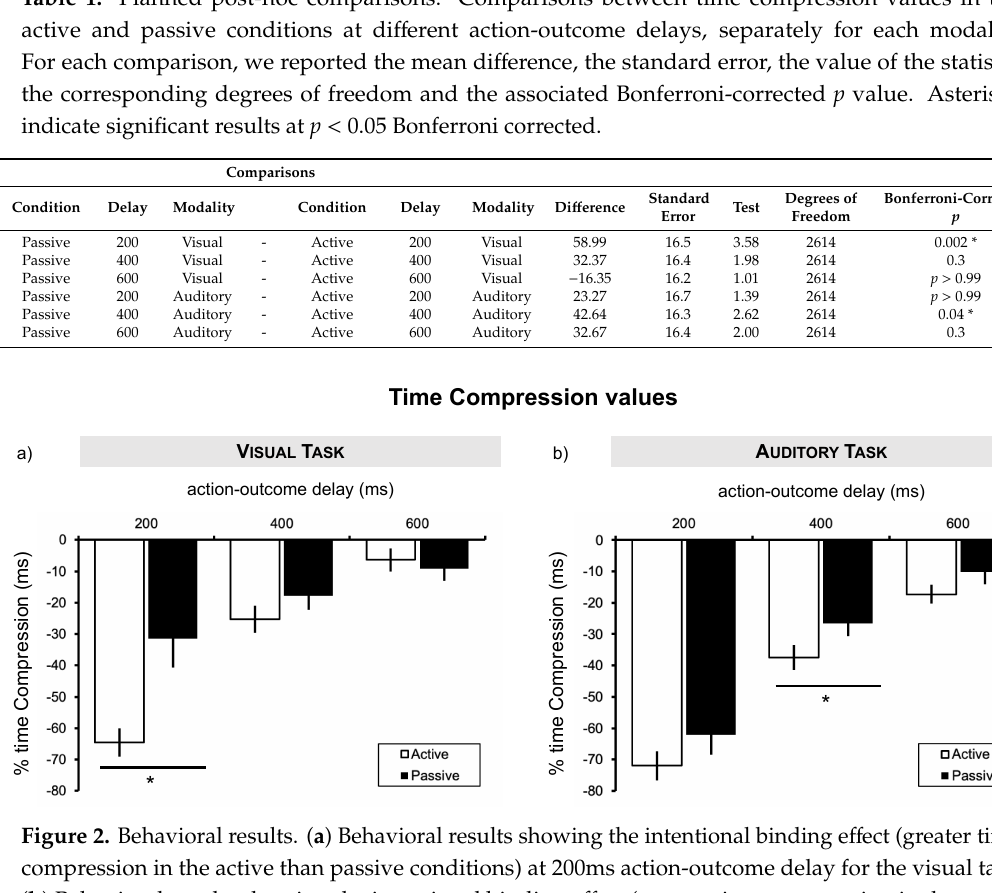
Table 1. Planned post-hoc comparisons. Comparisons between time compression values in the active and passive conditions at different action-outcome delays, separately for each modality. For each comparison, we reported the mean difference, the standard error, the value of the statistic, the corresponding degrees of freedom and the associated Bonferroni-corrected p value. Asterisks indicate significant results at p < 0.05 Bonferroni corrected .